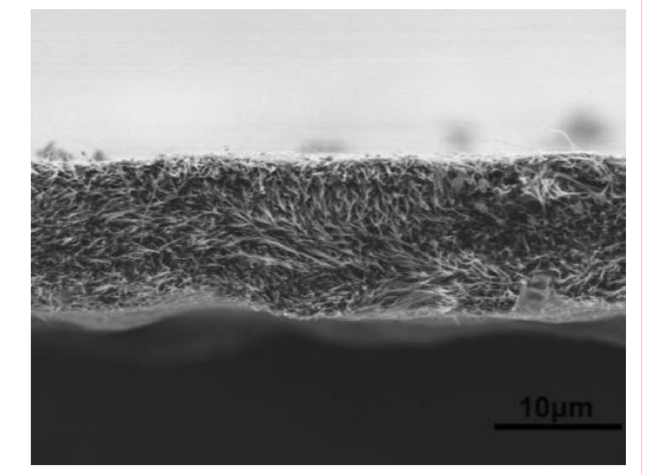
Figure 9. SEM micrographs of tensile fracture surface of CNT/polyimide composite. Reproduced from